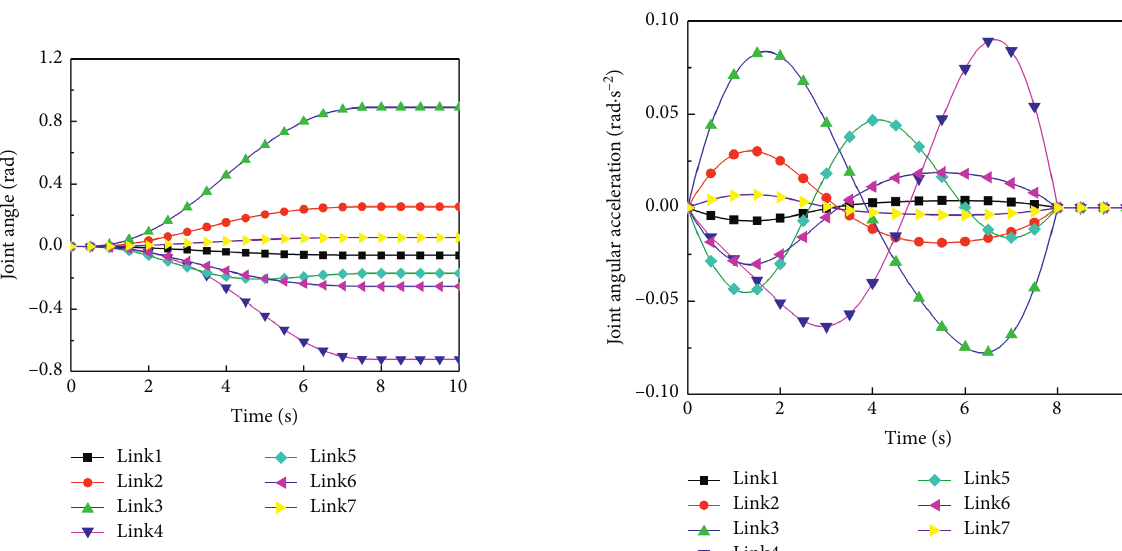
Figure 4: Terminal line velocity planning (m/s).